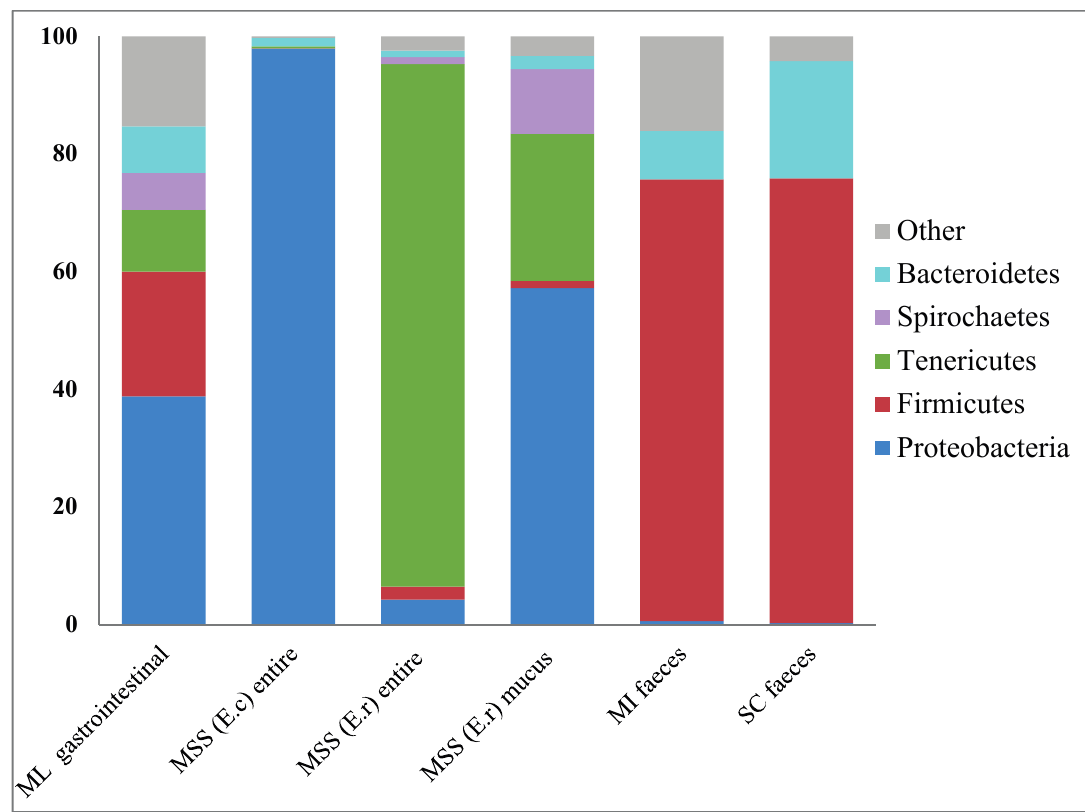
Figure 3. Comparison of the Phylum level microbiome associated with P. pellucida gastrointestinal tract to those associated with other seaweed and sea grass grazers: ML-Marine Limpet P. pellucida ; MSS (E.c)-Marine Sea Slug Elysia chlorotica ; MSS (E.r)-Marine Sea Slug Elysia rufescens ; MI-Marine Iguana Amblyrhynchus cristatus ; SC-Sea Cow Dugong dugon .